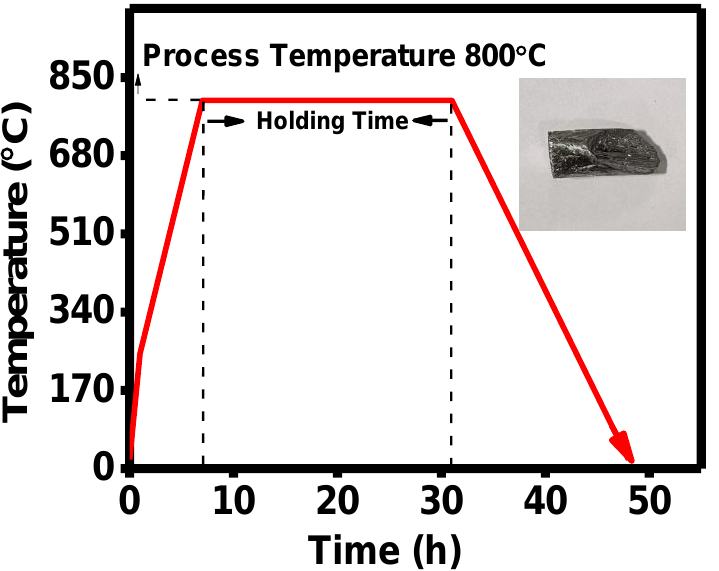
Figure 1. The temperature profile of material inside the vertical tube furnace (inset: single crystal ingot of Sb 2 Se 3 ).